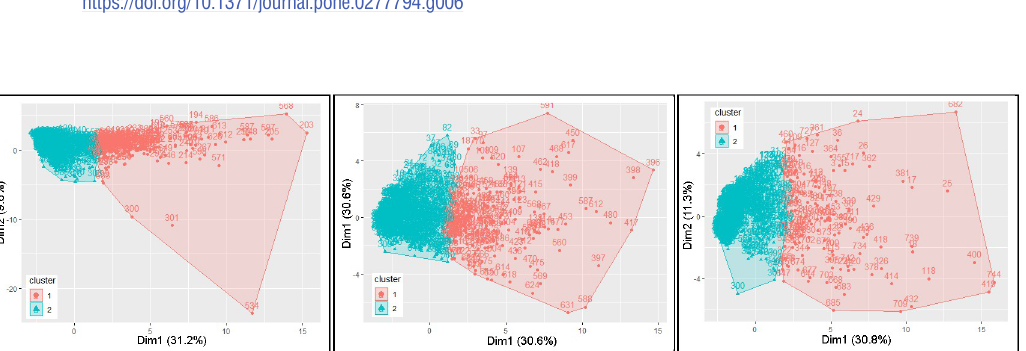
Fig 6. BNM configuration for Straw-necked Ibis including conditional probabilities and indicative variables for high and low collision likelihood. Node influence strength is given by the width of connecting arcs.